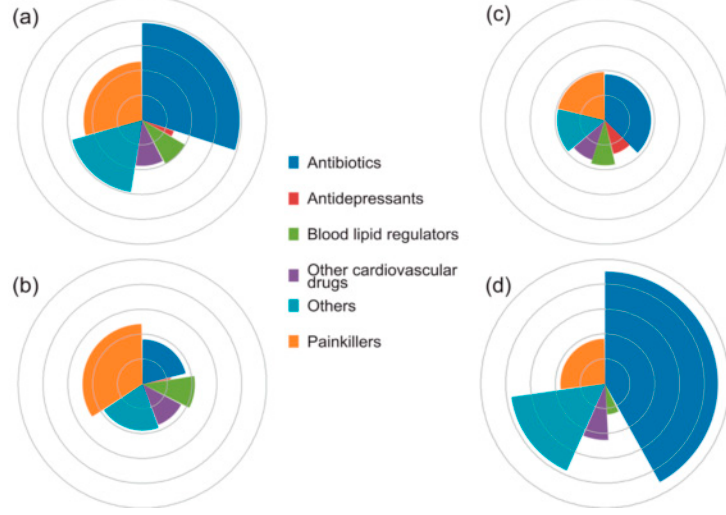
Figure 1. According to reference [2] *: Relative frequency of detection and median concentration of pharmaceuticals in receiving waters: ( a ) global; ( b ) Europe; ( c ) North America; and ( d ) Asia. (The circumference of each fan is scaled by the relative proportion of detections. Each point outward on the radial axis represents 10 y of the median concentration in ng L − 1 . For example, the innermost circle represents 10 1 ng L − 1 ; the second represents 10 2 ng L − 1 , etc.). * pubs.acs.org/doi/full/10.1021/es3030148, further permissions related to the material excerpted should be directed to the ACS.